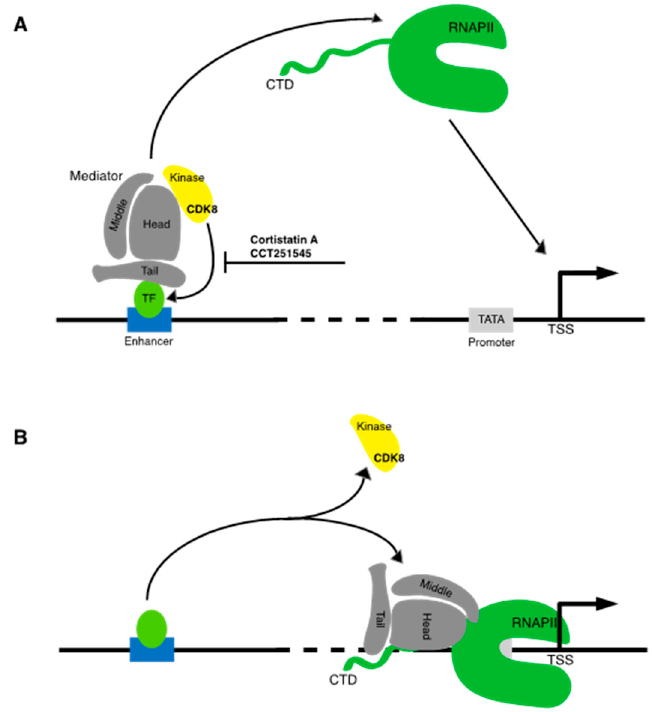
Figure 1. Modulation of gene-specific transcription factor function by Mediator-associated kinase CDK8. ( A ) Transient interaction of Mediator with a transcription factor (TF) bound at an enhancer allows modulation of transcription factor function by CDK8, perhaps through direct phosphorylation. CDK8 inhibitors discussed in the text are indicated. “Head,” “middle,” “tail,” and “kinase” refer to modules of the Mediator complex. CTD = RPB1 C-terminal domain; TSS = transcription start site. The dashed line indicates the variable distance between enhancer and promoter sequences. General transcription factors bound to the promoter with RNA polymerase II (RNAPII) are omitted for clarity. ( B ) Following interaction with gene-specific transcription factors, Mediator associates with RNAPII at the core promoter site to activate transcription. The kinase module is released.